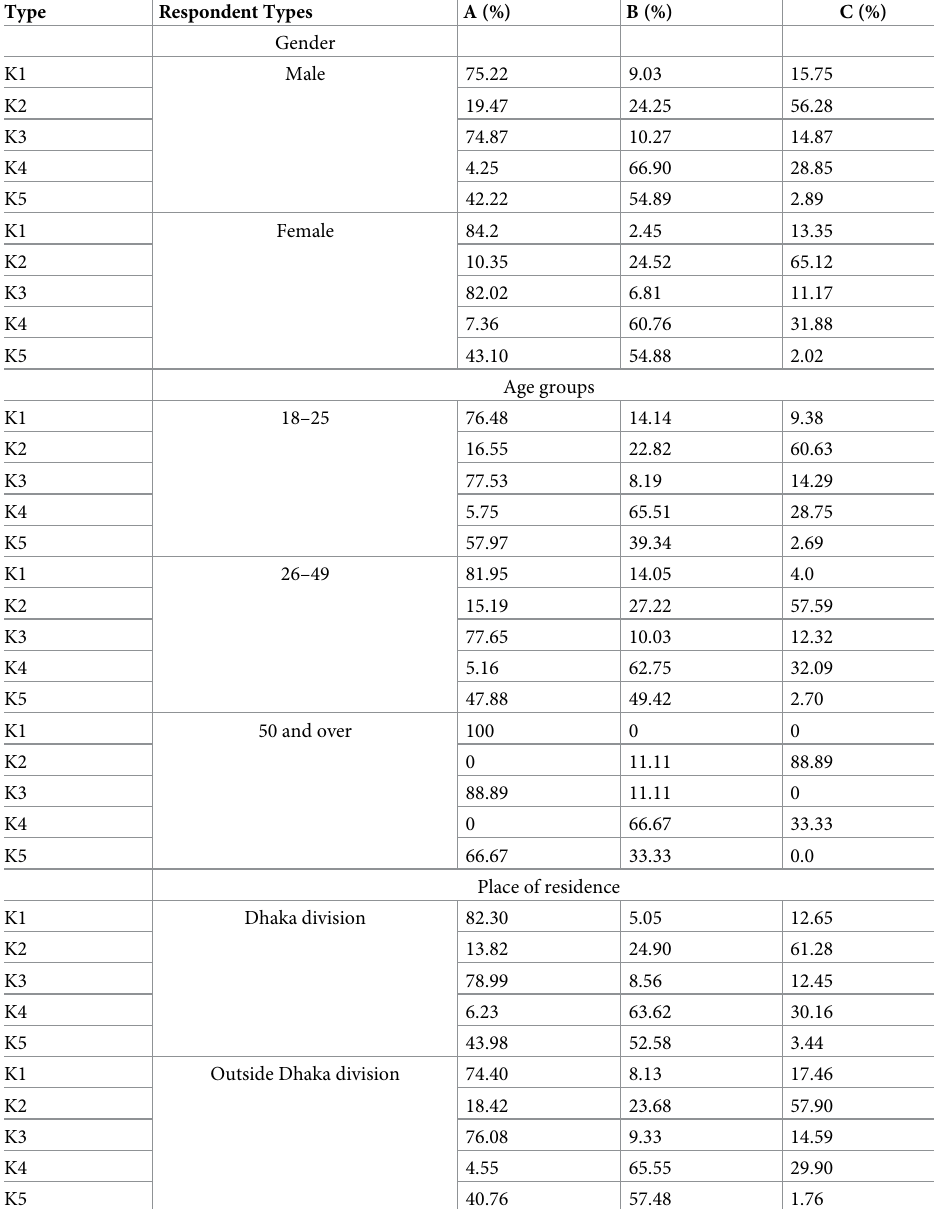
Table 3. Distribution of knowledge related characteristics among the